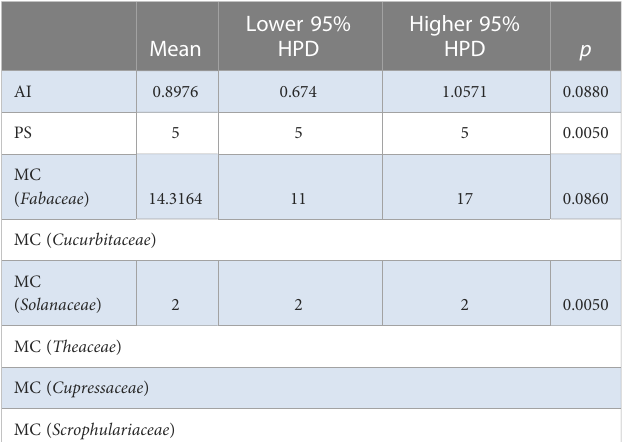
TABLE 5 BaTS algorithm analysis for for the Chinese AMV population based on host species level.